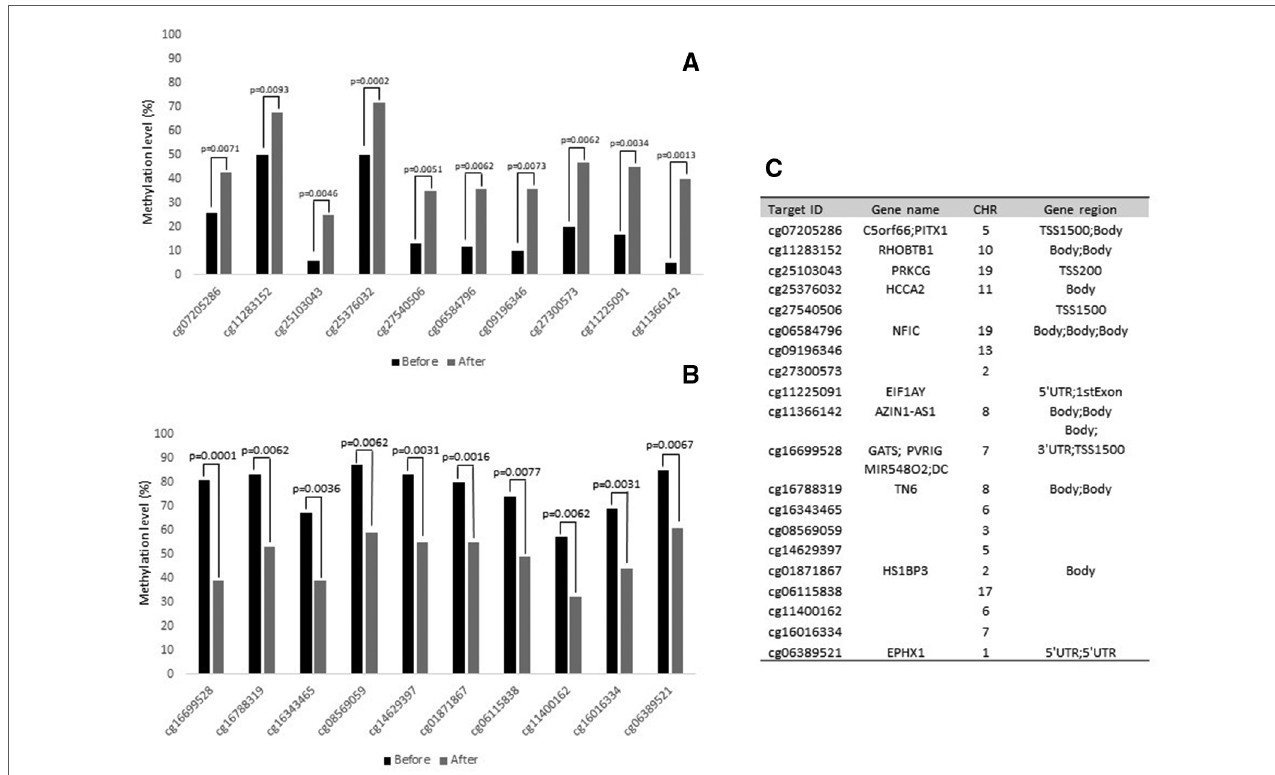
FIGURE 1 Top 20 CpG sites that were differently methylated after physical intervention in bariatric surgery women. ( A ): Hypermethylated CpGs sites after intervention. ( B ): Hypomethylated CpGs sites after intervention. ( C ): Characteristics of CpG sites. CHR: